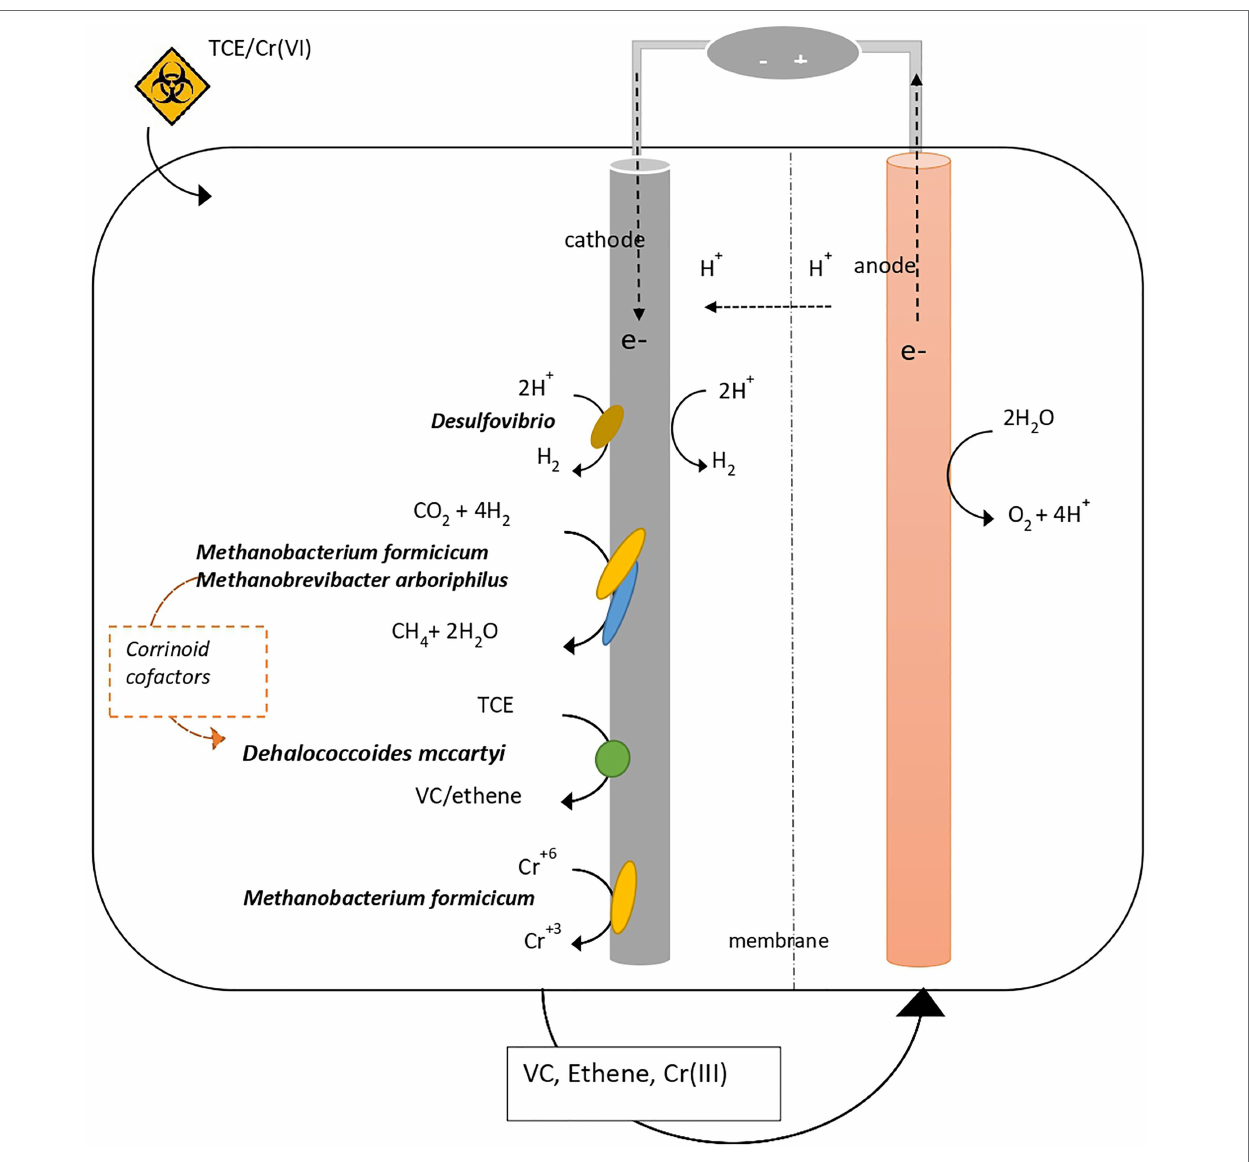
FIGURE 7 | Microbial interactions revealed at the biocathode of the bioelectrochemical system where RD, hydrogenotrophic methanogenesis, and Cr(VI) reduction